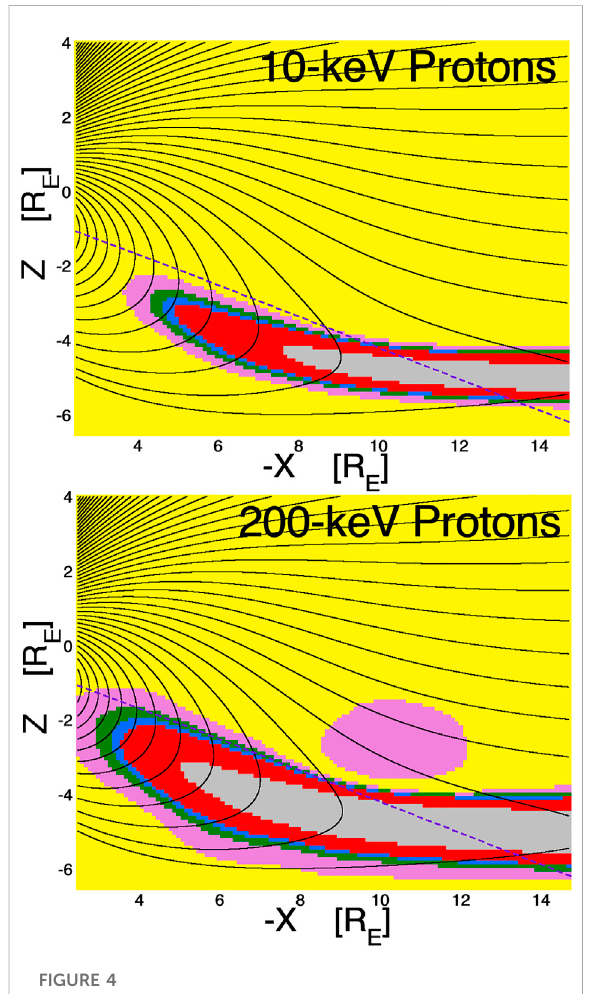
FIGURE 5 Loss-cone-shift maps for oxygen O + . Magnetic- fi eld lines in the nightside magnetosphere in the noon-midnight meridian are drawn as the black curves using the T96 magnetic- fi eld model. The colored shading is the calculated westward angular shift of the local atmospheric loss cone for 10-keV O + (top panel) and for 200-keV O + (bottom panels) based on the T96 magnetic- fi eld model. The color scheme is yellow (shift < 0.5 ° ), pink (shift 0.5 ° – 1 ° ),